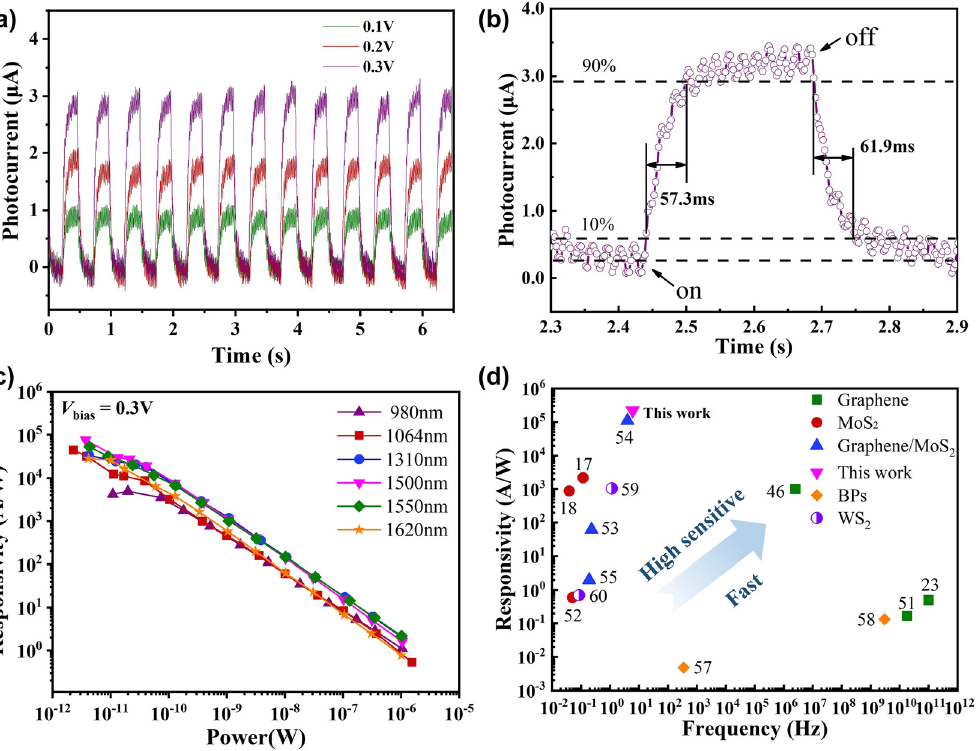
Figure 6: Time and wavelength dependent response. (a)Time dependent photocurrentof the deviceoperatingat a bias voltageof 0.1 V (blackline),0.2V (red line),0.3V (blue line)at incidentlight power of 47.9 mW at 1550 nm; (b) the enlarged view of photocurrent at 0.3 V shows the rise time and the fall times are 57.3 and 61.9 ms, respectively; (c) responsivities as a function of the optical power for different illumination wavelengths (980, 1064, 1310, 1500, 1550 and 1620 nm); (d) comparison of the responsivityand bandwidth for the photodetectors based ongraphene, MoS 2 , WS 2 , BPsand graphene/MoS 2